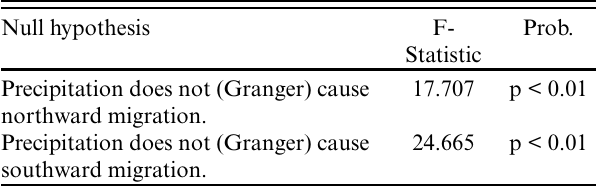
Table 5 . Granger causality analysis of precipitation and northward/southward